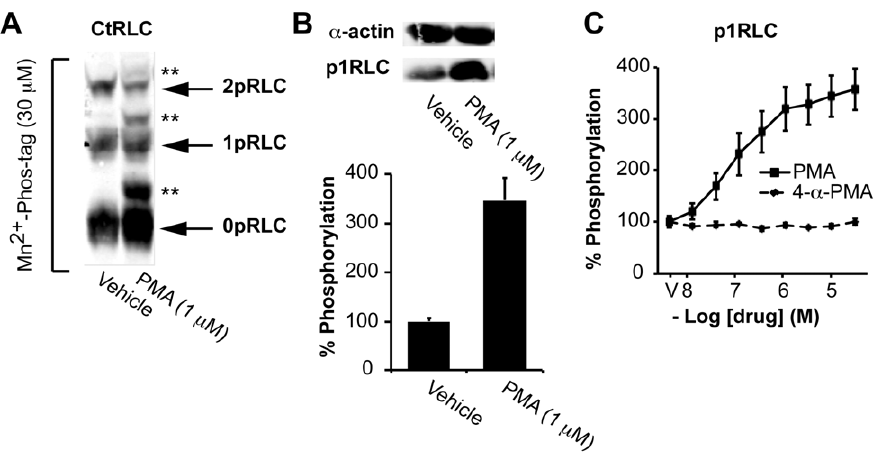
Figure 6. PMA induces phosphorylation of RLC at S1 and alters mobility of phospho-RLC during phos-tag SDS-PAGE. A. WBs produced by Mn 2 + -phos-tag separation of lysates from uterine myocytes treated with PMA (1 m M) or vehicle. The membranes were probed with an Ab directed against the C- terminus of total-RLC (CtRLC). 0pRLC, 1pRLC, and 2pRLC correspond to non-, mono-, and di-phosphorylated RLC. The bands labeled with ** exhibit unexpected mobility in the Mn 2 + -phos-tag acrylamide matrix. B. Traditional WBs demonstrating phosphorylation of RLC at S1 (p1RLC) in uterine myocytes treated with PMA. C. Quantification of p1RLC concentrations in uterine myocytes treated with PMA and 4- a -PMA (negative control) by the in-cell western method. In B and C , the data represent 4 independent experiments and are presented as means 6